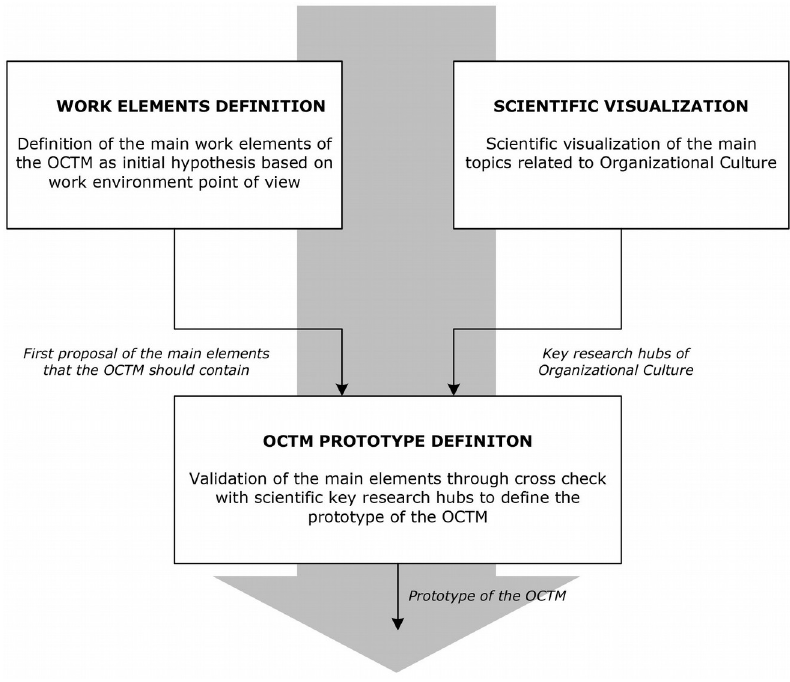
Figure 4. Main workflow of the research